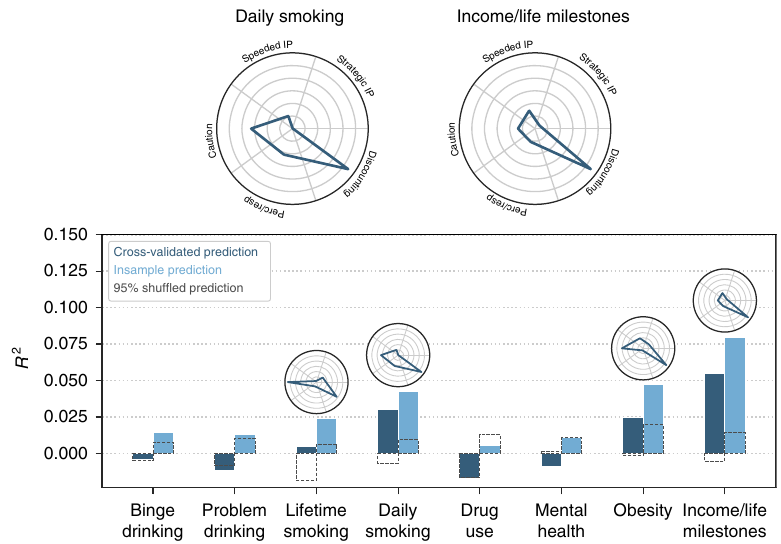
Fig. 7 Prediction of target outcomes using task factor scores. Identical to Fig. 6, except for the truncated y -axis; the task factors are substantially worse at explaining variance in the target outcomes. IP: information